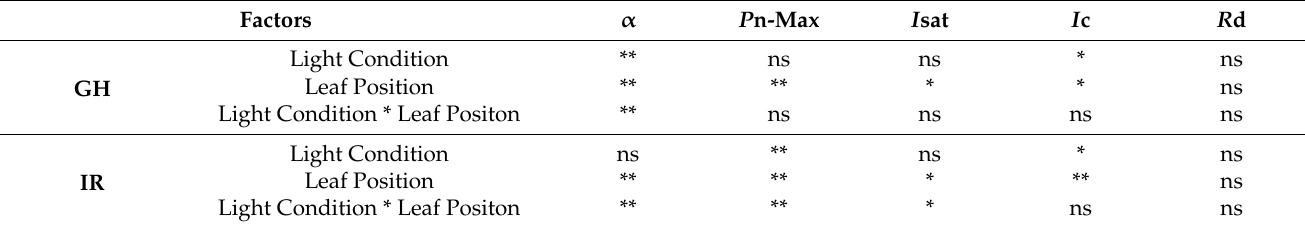
Table 3. Results of two-way ANOVA, for photosynthetic parameters and light conditions and leaf position. Factors